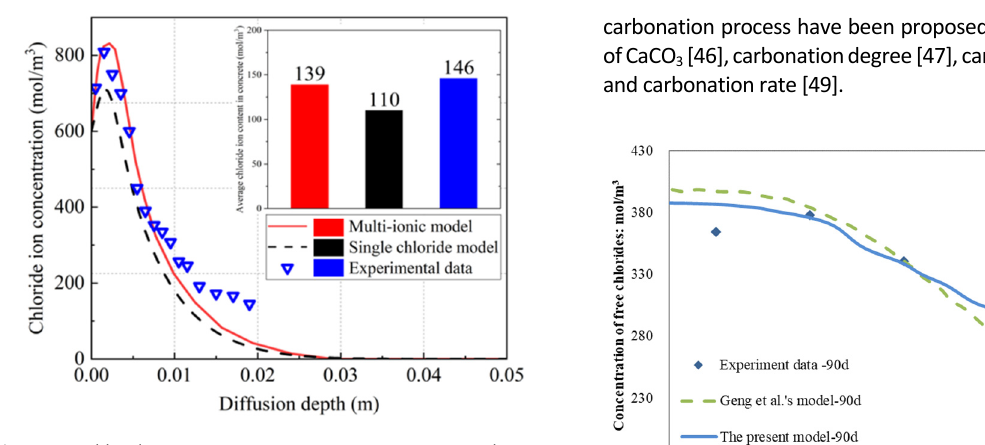
Figure 3. Chloride concentration comparison among multi ‐ ionic model, single chloride species model and experimental data after 10 drying ‐ wetting cycles. Adapted from [42].